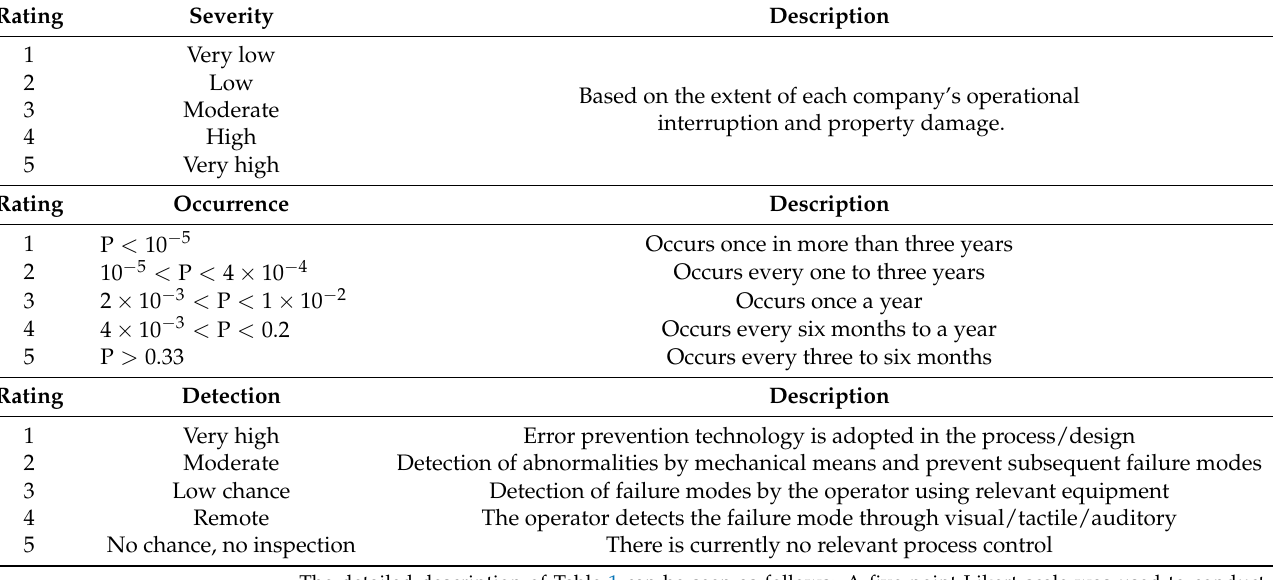
Table 1. The rating guidance of risk factors.